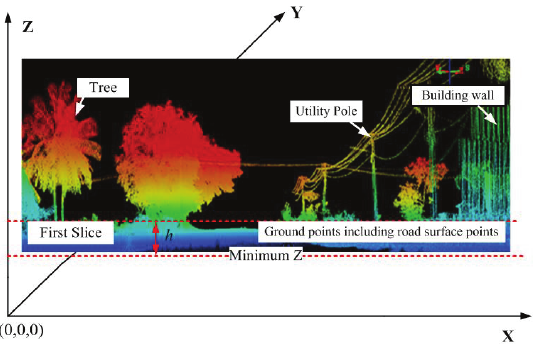
Figure 1. Rough ground classification by clustering. Points lie within range of minimum Z to